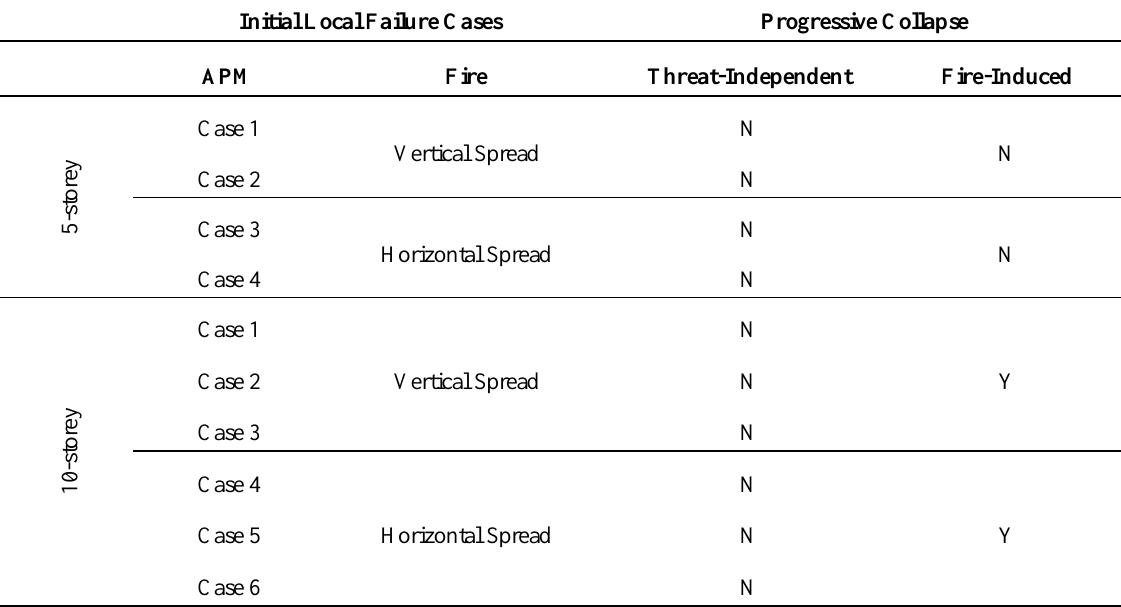
Table 4. Summary of progressive collapse